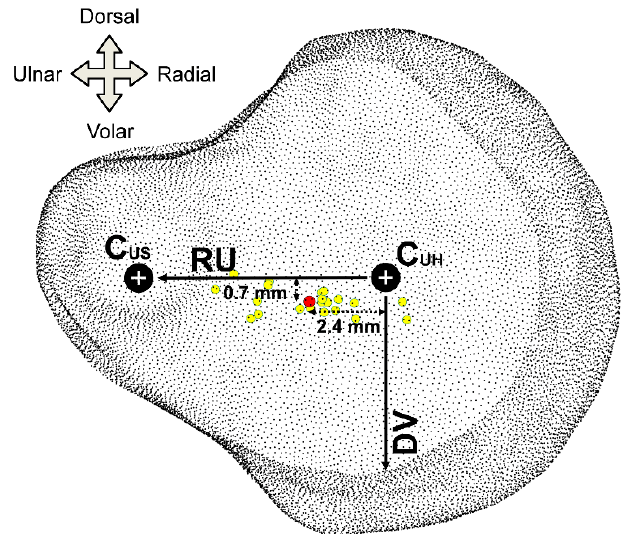
Figure 3 . The distribution and average location of the RCs in the 21 patients. The yellow spots represent the RCs in the 21 patients. The average location of the RCs on the ulnar head (the red spot) was 2.4 mm ± 1.5 ulnarly and 0.7 mm ± 0.7 volarly from the center of the ulnar head. Each spot on the figure represents the relative location on the mean size model.